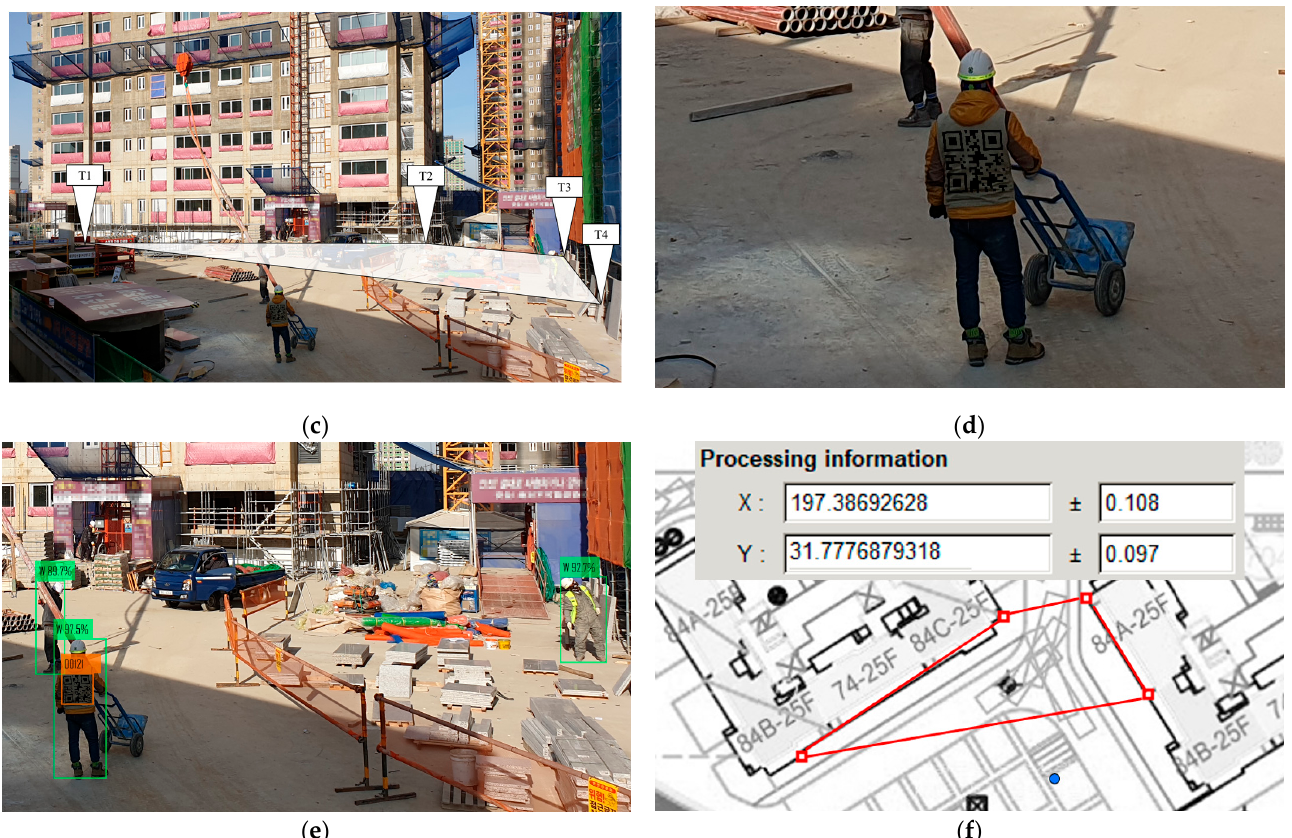
Figure 9. Applying process and results of case study: ( a ) location of the camera installed on-site and 4 points to be used as the location standard; ( b ) on-site video file; ( c ) polygon plane created from 4 points (T1~T4) set in the image; ( d ) QR code drawn on clothes with a stencil technique to identify each worker’s ID; ( e ) identification result of each object and reading result of QR code information; ( f ) estimating the location of the operator “00121” and marking the location on the map.